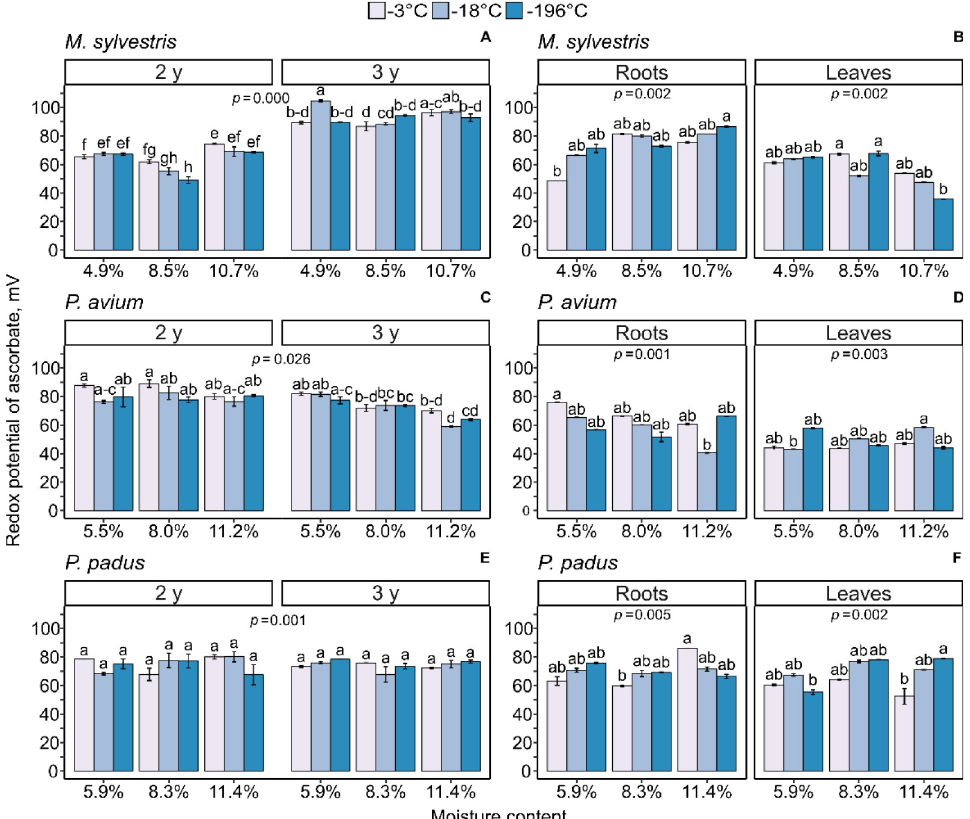
Fig 4. Changes in the levels of redox potential reported in germinated seeds (A, C, E) and 3-month-old seedlings derived from the seeds (B, D, F) of M . sylvestris (A, B), P . avium (C, D) and P . padus (E, F). In germinated seeds, redox potential level between MC x storage temperature x storage time was compared. In 3-month seedlings, the level of redox potential was measured in leaves and roots. Data are the means ± standard error obtained from three independent experiments with similar results. Statistically significant differences are indicated with different letters among the groups, followed by Tukey’s test for seeds and Dunn’s test for seedlings at p � 0.05.